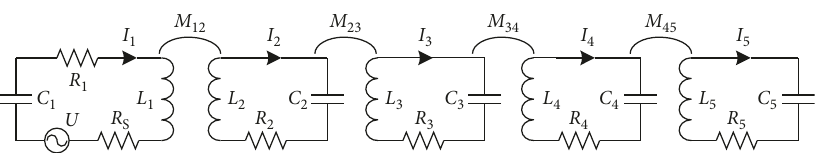
Figure 5: Equivalent circuit model for a five-coil wireless energy transfer system.